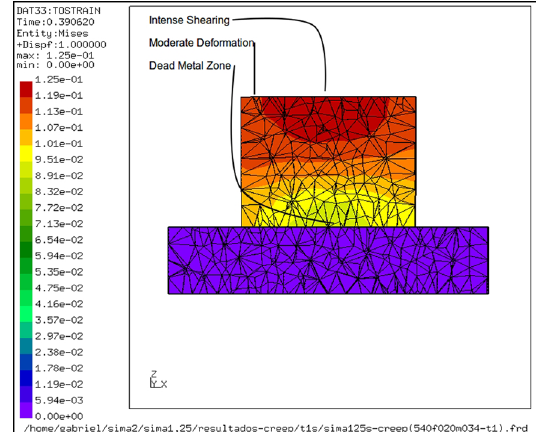
Figure 8. Cut view of the Von Mises equivalent strain for a copper at 540 °C, tested under compression with a strain rate